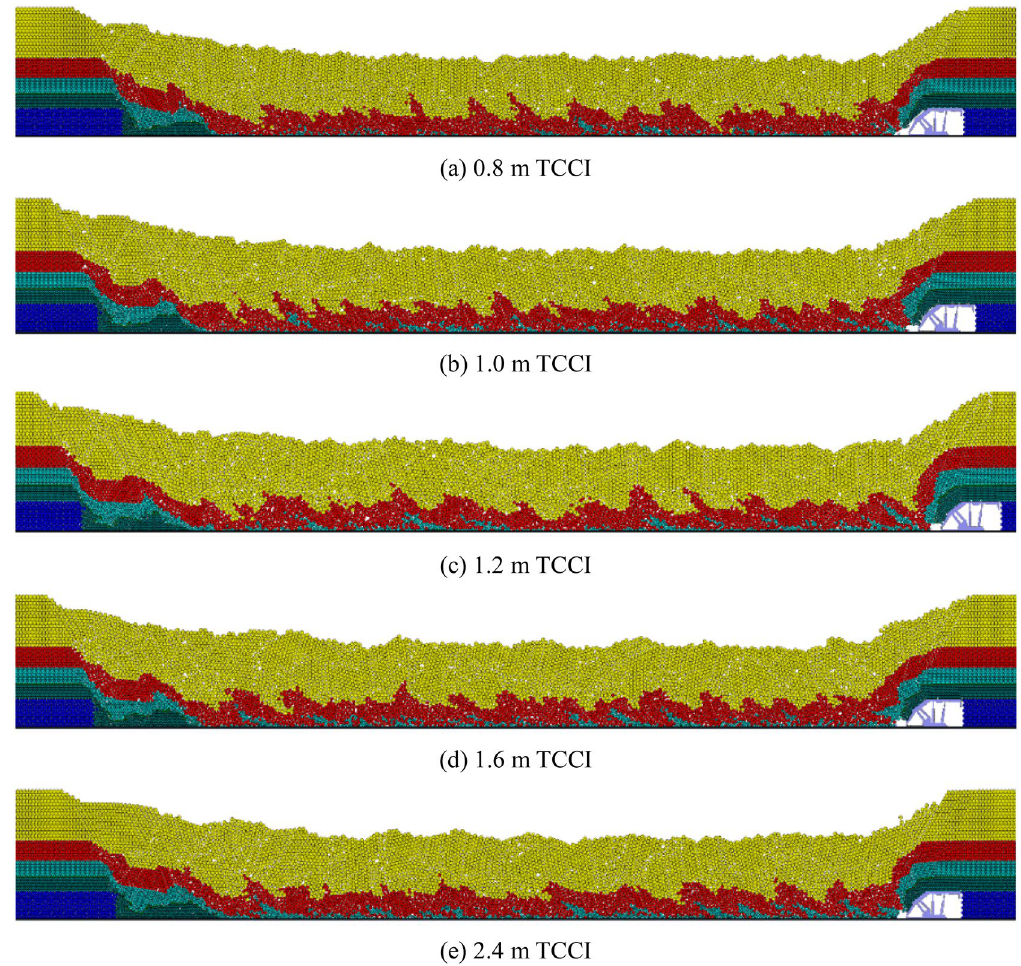
Figure 4. Loss of top coal in different coal-drawing interval under 4.0 m top coal